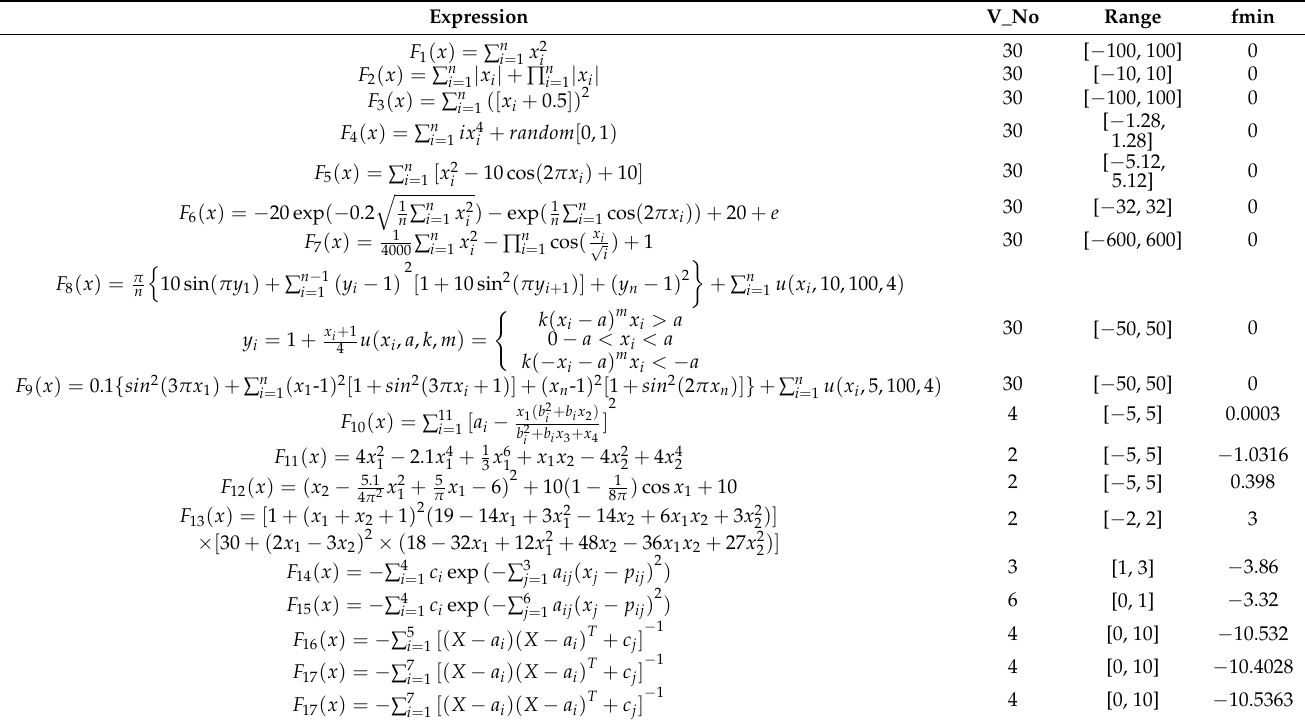
Table 1. Details of 18 benchmark